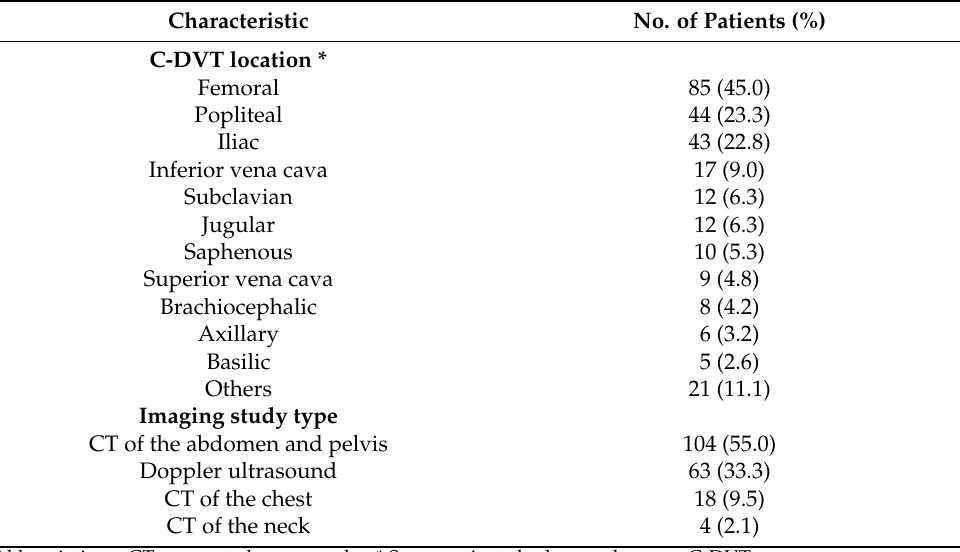
Table 2. Characteristics of concomitant deep vein thrombosis (C-DVT) in cancer patients with unsuspected pulmonary embolism ( n =